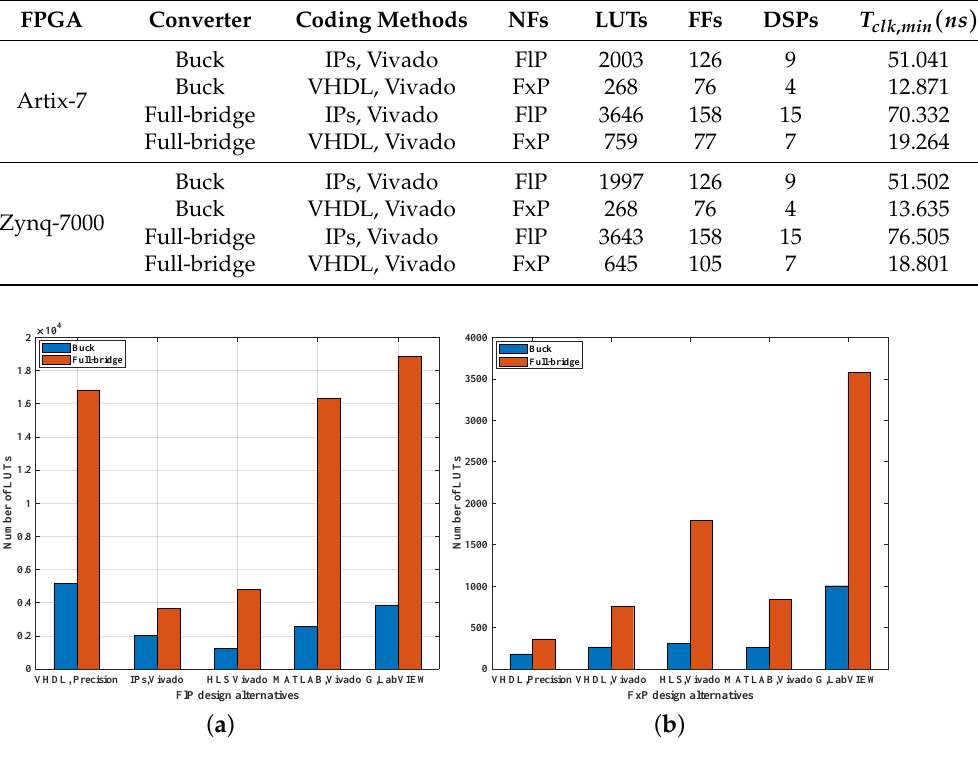
Figure 5. Number of LUTS for different design alternatives; ( a ) Floating-point design possibilities, ( b ) Fixed-point design